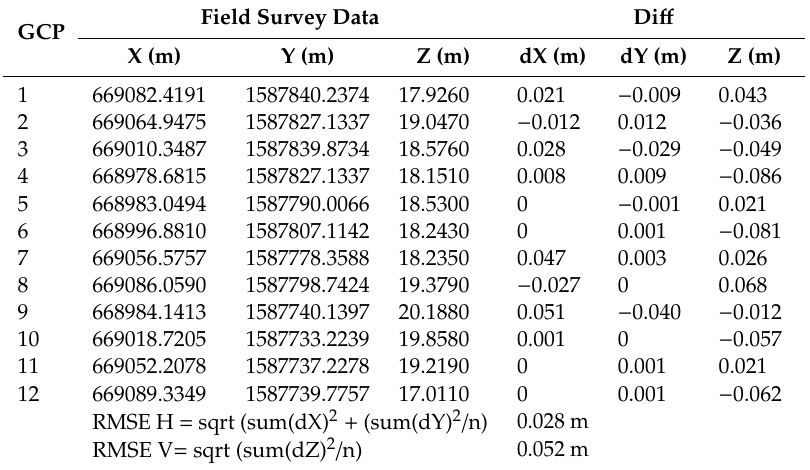
Table 2. Unmanned aerial vehicle structure-from-motion’s (UAV-SfM) model accuracy assessment.